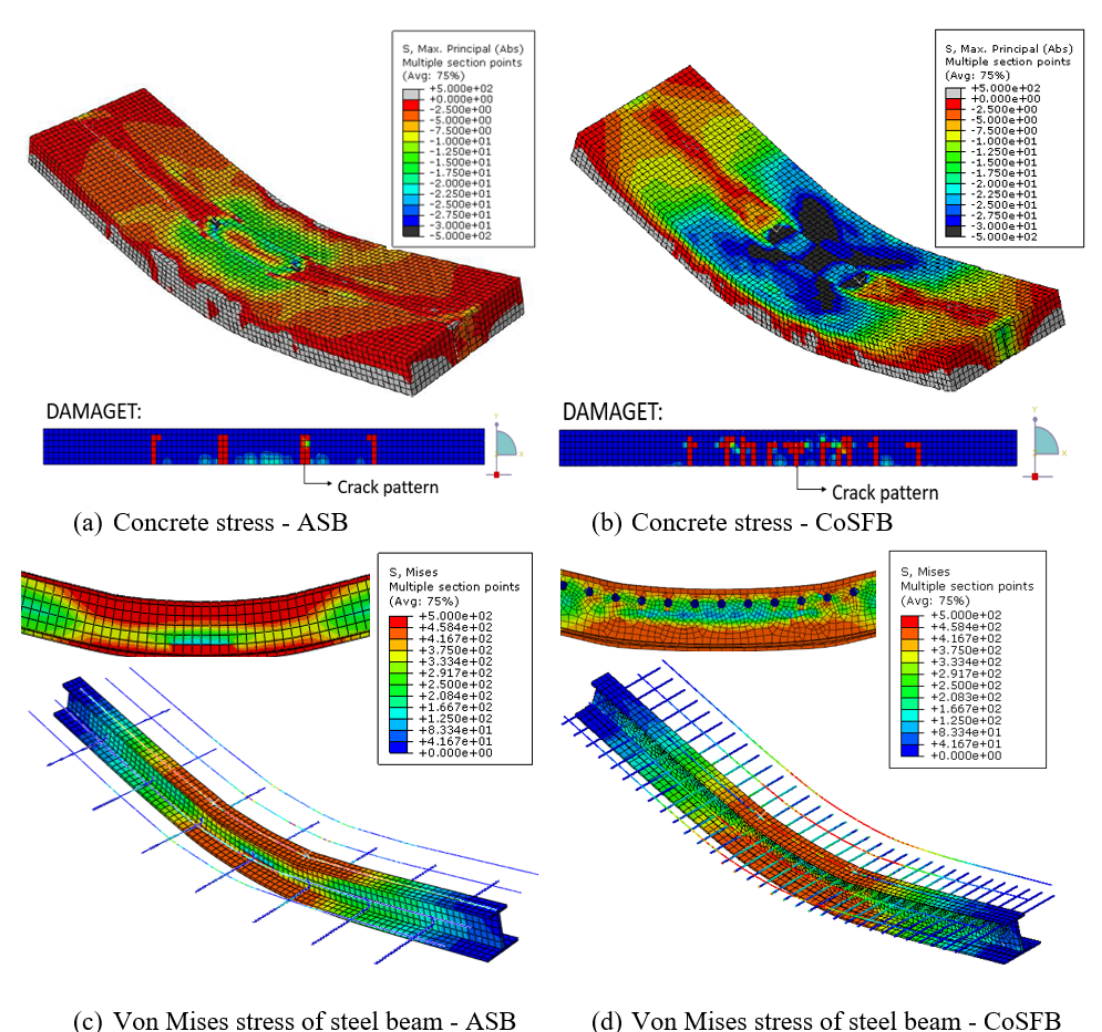
Figure 18. Stress of concrete and steel beam at the ultimate loads (measurements in